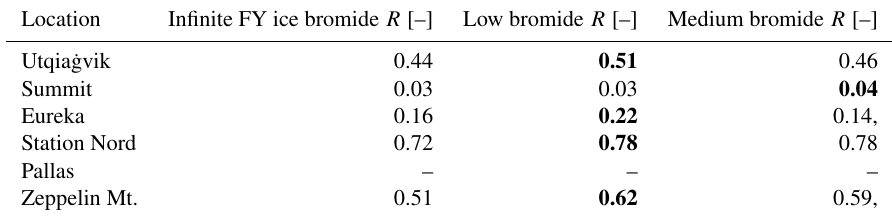
Table 5. Correlation coefficient at different locations from 1 February to 1 May 2019 for the three different simulations in order. The best value is marked in bold. The correlation coefficients for Pallas station are discarded due to poor